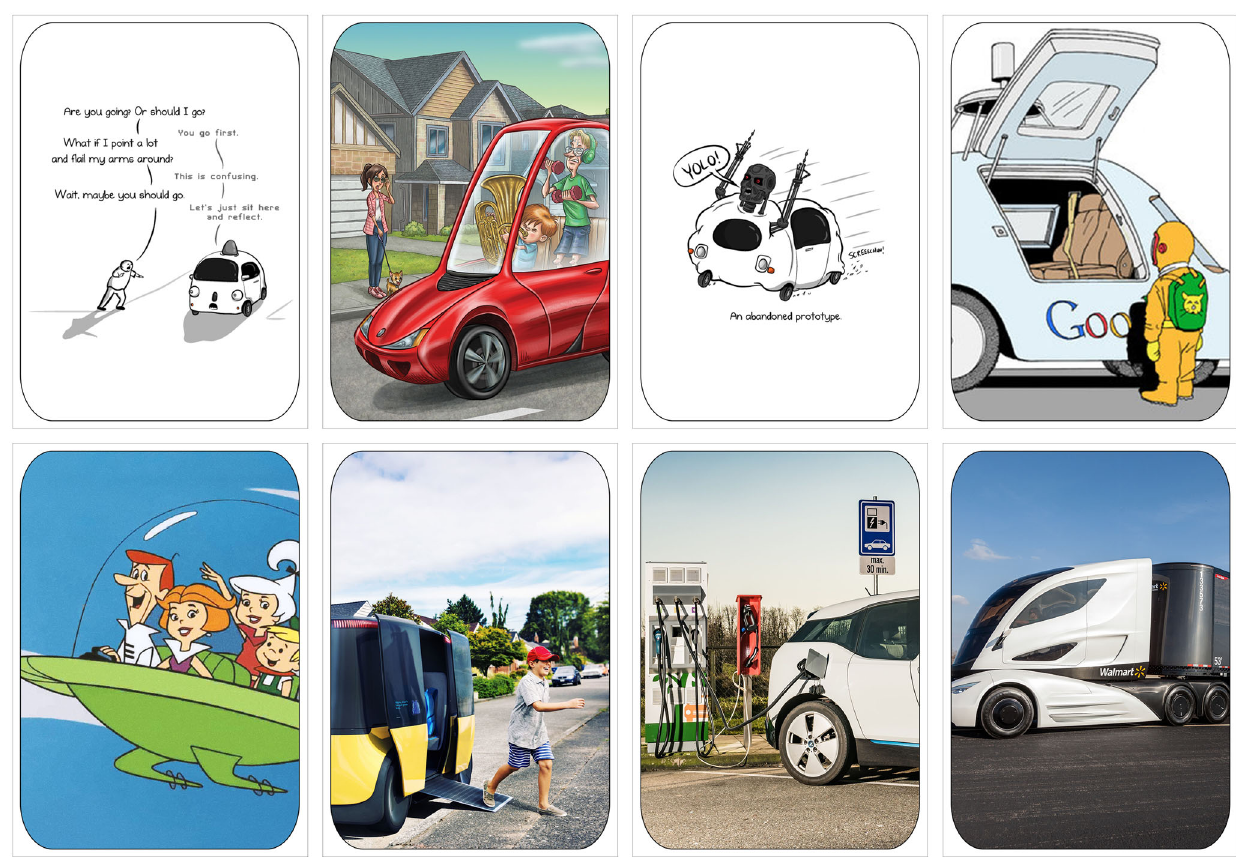
Fig. 1 CAV cards visual. Visual of ‘ CAV Cards ’ developed by the Joint Research Centre ’ s (JRC) Connected and Automated Vehicles (CAVs) pilot project with imagery from several public